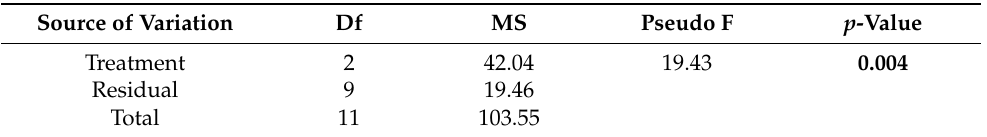
Table 3. One-way permutation analysis of variance (PERMANOVA) results on % budding rates. Statistical significance for the treatment was tested under a null model (9999 permutations). MS: mean squares. In bold, p -value < 0.005.